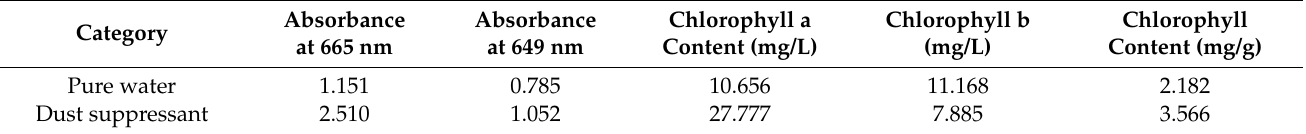
Table 8. Measurement results on chlorophyll contents in plants.